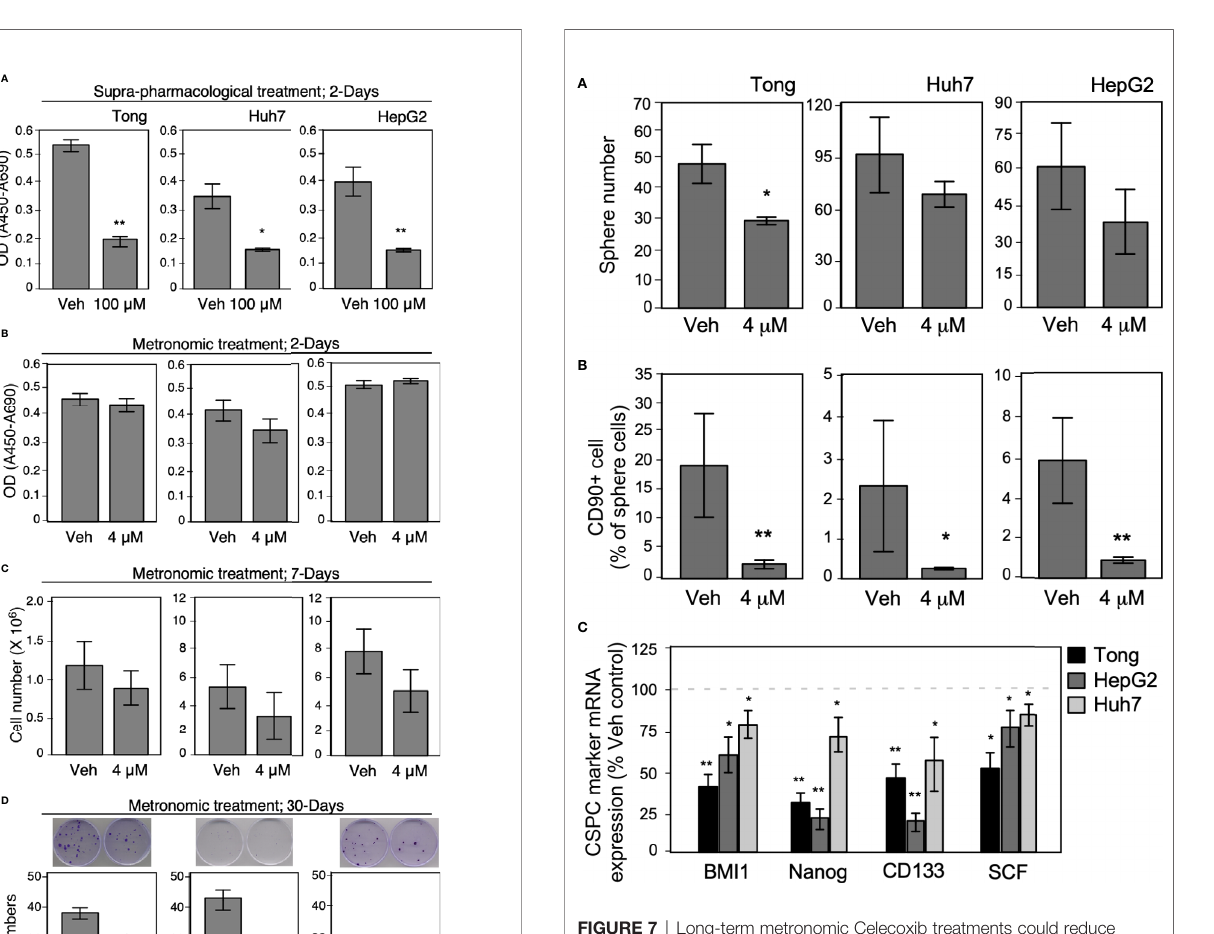
FIGURE 7 | Long-term metronomic Celecoxib treatments could reduce CSPC self-renew capacity and CD90+ cell population in CSPC sphere cells. (A) Long-term metronomic Celecoxib treatments reduce HCC cells (Tong, Huh7, and HepG2) CSPC self-renewal. The HCC cells (500 cell/plate) were plated onto low-attachment 60-mm dishes with sphere-forming medium (low serum), treated with or without Celecoxib (4 m M; 21 days). The sphere number was counted, and the values were plotted on the graph. (B) Long- term metronomic Celecoxib treatments reduce CD90+ populations in the sphere cells. The cells from (A) were harvested, fi xed with cold-methanol, stained with CD90 antibody, then observed CD90+ population by fl ow cytometry. The CD90+ percentage was plotted on the graph. (C) Long-term metronomic Celecoxib treatments reduce CSPC maker genes of the sphere cells. The cells from (A) were harvested, and the total RNA was extracted. CSPC marker genes expression (BMI1, Nanog, CD133, and SCF) was measured using real-time RT-PCR. The value was compared with vehicle treatment and plotted on the graph as % of Veh. control. The actin expressions were used as loading control of each set of experiments. The data were from at least three reproducible independent sets of the experiment, and the mean values with standard errors were plotted graphically. * Indicates P < 0.05 and ** indicates P < in the spheres was considerably lower among Celecoxib-treated cells than among vehicle-treated cells ( Figure 7B ). Finally, we determined the expression level of CSPC markers using Q-RT-PCR after metronomic Celecoxib treatment. The mRNA expression levels of BMI1, Nanog, CD133, and SCF were signi fi cantly lower in Celecoxib-treated HCC cells than in vehicle-treated HCC cells (p-values of CSPS markers: BMI1, Nanog, CD133 < 0.01, SCF < 0.05 in Tong cells; Nanog, CD133 < 0.01, and BMI1, SCF < 0.05 in